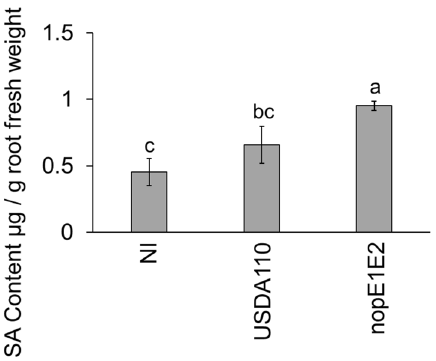
Figure 7. The salicylic acid content in V. radiata roots was determined: noninoculation (NI), USDA110 inoculation (USDA110), and double mutant strain of nopE1 and nopE2 (nopE1E2) inoculation. The means followed by different letters are significantly different at P < 0.05 is indicated by the means ± standard deviations (n =